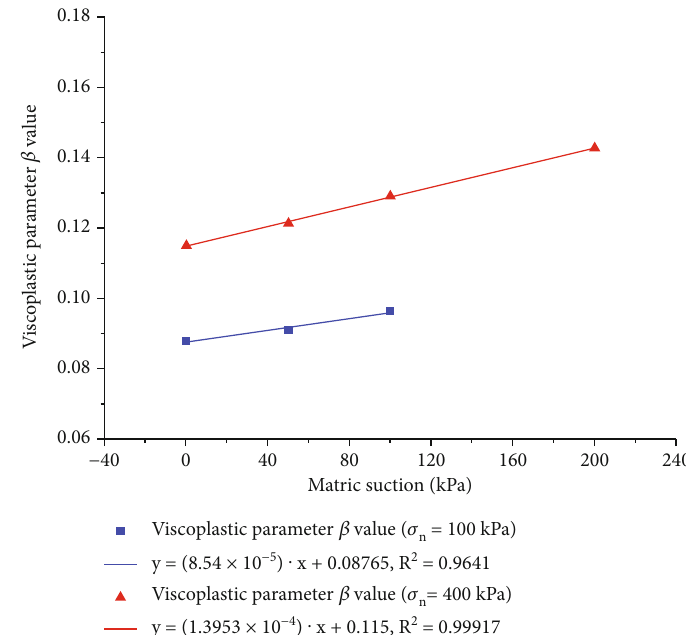
Figure 11: Relationship between β value of reticulate red clay and matric